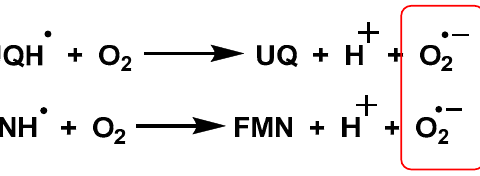
Figure 10. The mitochondrial production of superoxide radicals is carried out through two fundamen- tal reactions: the oxidation of ubiquinol UQ and the autoxidation of flavin by FMNH dehydrogenase.